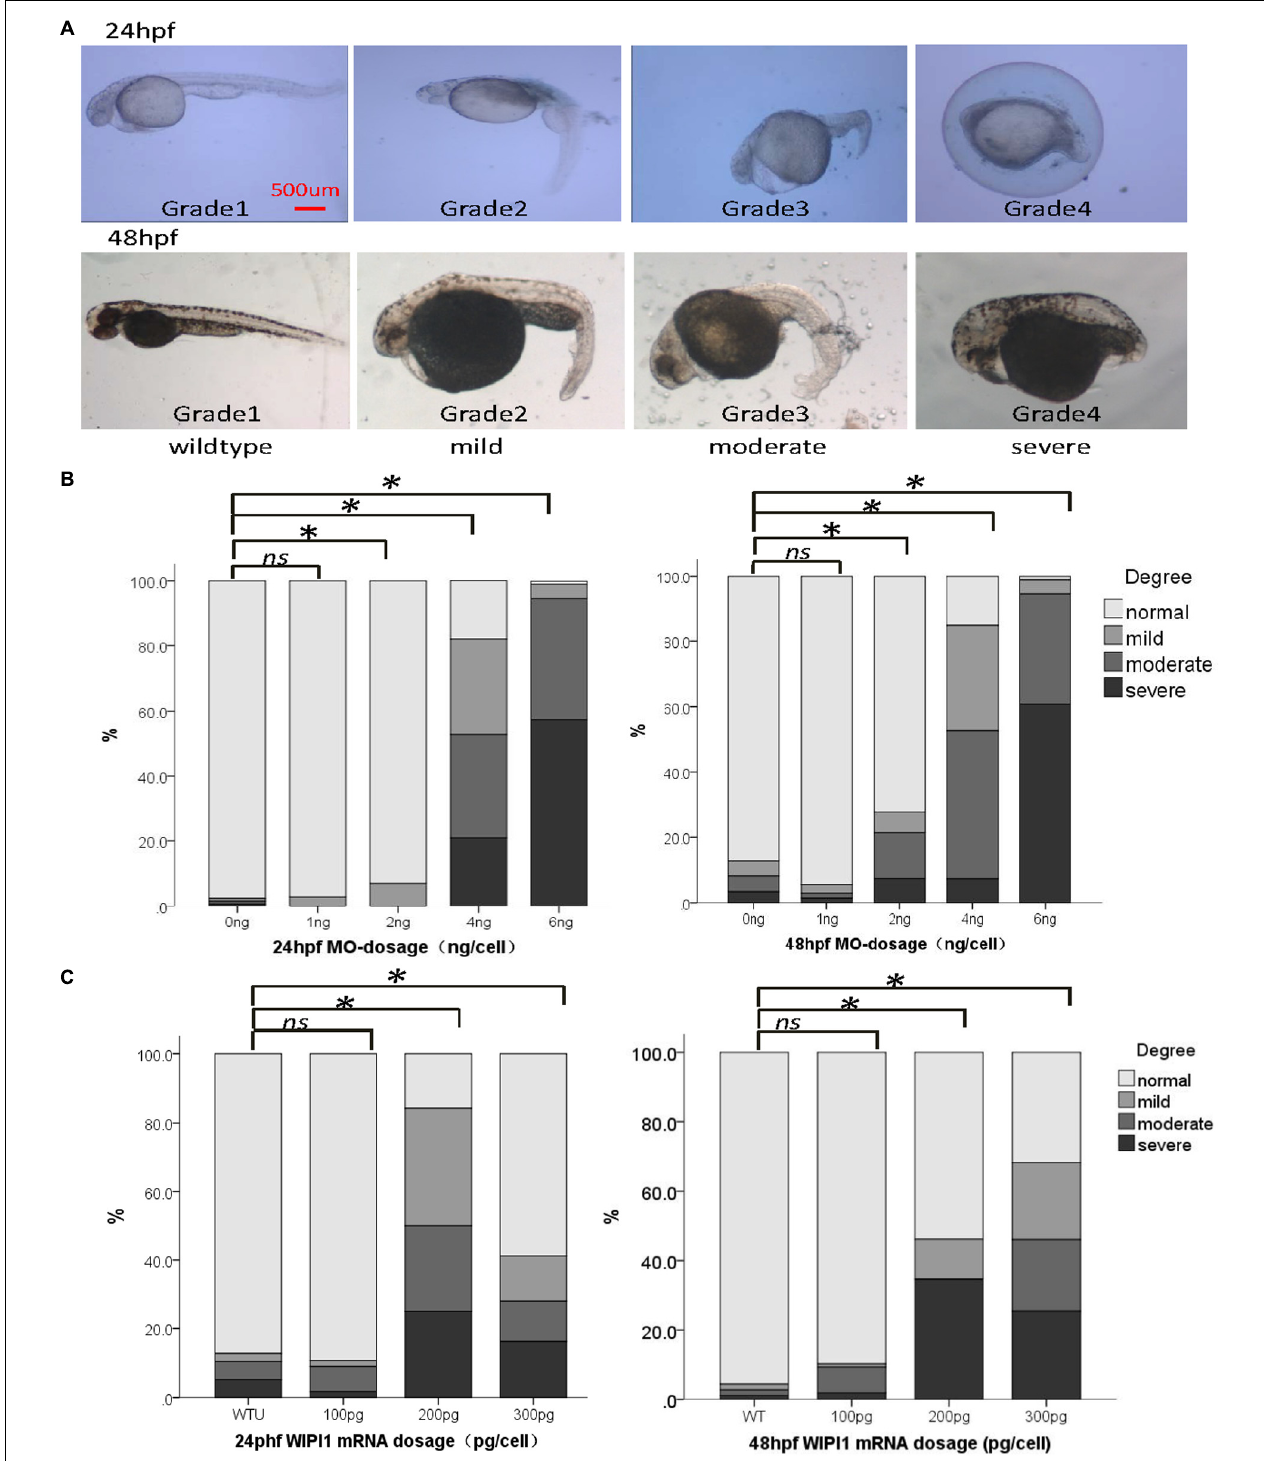
FIGURE 2 | Abnormal expression of wipi1 affected zebrafish embryo convergent extension. (A) Zebrafish embryos injected with wipi1- MO (antisense morpholino) show defects of convergent extension, including shortening of the trunk, and crooked or bent tails. To assess the extension defects quantitatively, the phenotypic classes were scored as grade 1 (normal), grade 2 (mild), grade 3 (moderate), and grade 4 (severe) in zebrafish embryos at 24 and 48 h post-fertilization (hpf) (scale bar = 500 µ m). (B) Zebrafish embryos injected with wipi1 -MO exhibit dosage-dependent convergent extension deficits at 24 and 48 hpf. Injection with wipi1 -MO at dose of 2–6 ng showed a significant difference compared with control injection. (C) Overexpression of Wipi1 in zebrafish embryos at 24 and 48 hpf. Injection 200 pg mRNA and 300 pg mRNA resulted in a significant increase of malformed zebrafish. There was no correlation between mRNA dosage and severity of malformation ( ∗ P <